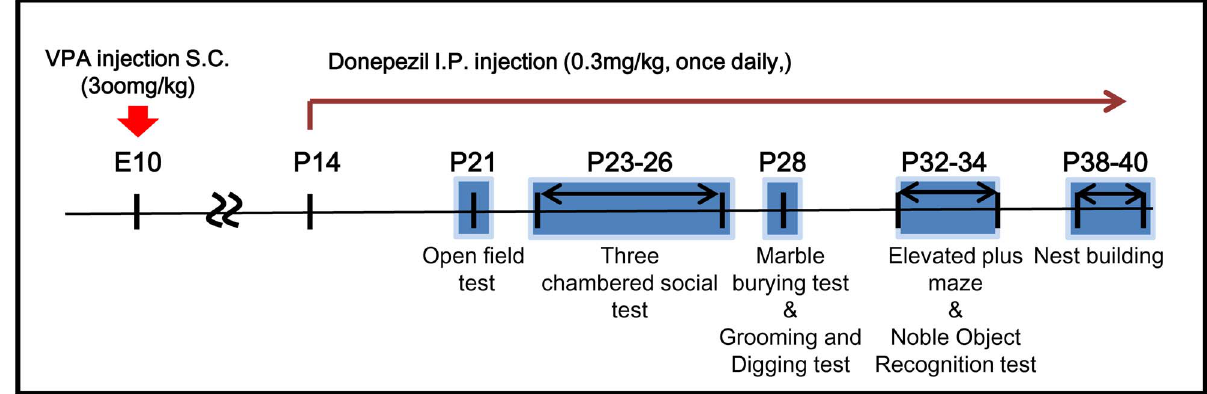
Figure 1. Drug treatment and behavioral study scheme with VPA mice. VPA was s.c. injected at embryonic day 10 (E10) to pregnant mice. Donepezil was i.p. injected once daily from postnatal day 14 (P14) until the end of the study. Behavioral studies were performed from P21. Grooming and digging test and novel object recognition tests were performed at 4 weeks of age with different sets of animals.